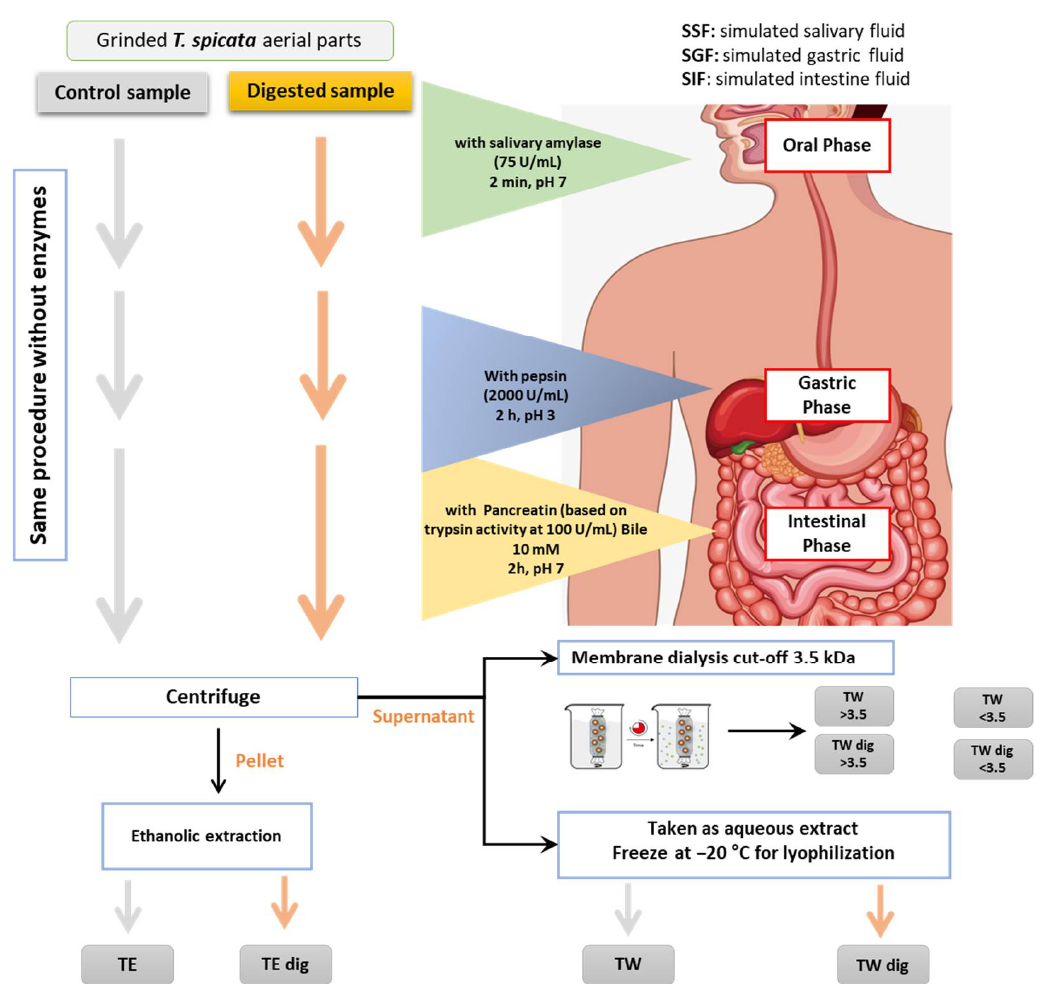
Figure 1. A schematic presentation describing the steps of the simulated digestion in the three phases: mouth, stomach, and intestine, in order to obtain the digested ethanolic (TE) and aqueous (TW) extracts. The same procedure was followed for preparation of crude extracts without the use of enzymatic digestion. The TW and TW dig were subjected to a membrane dialysis with a cut-off of 3.5 kDa to obtain low and high mw fractions.